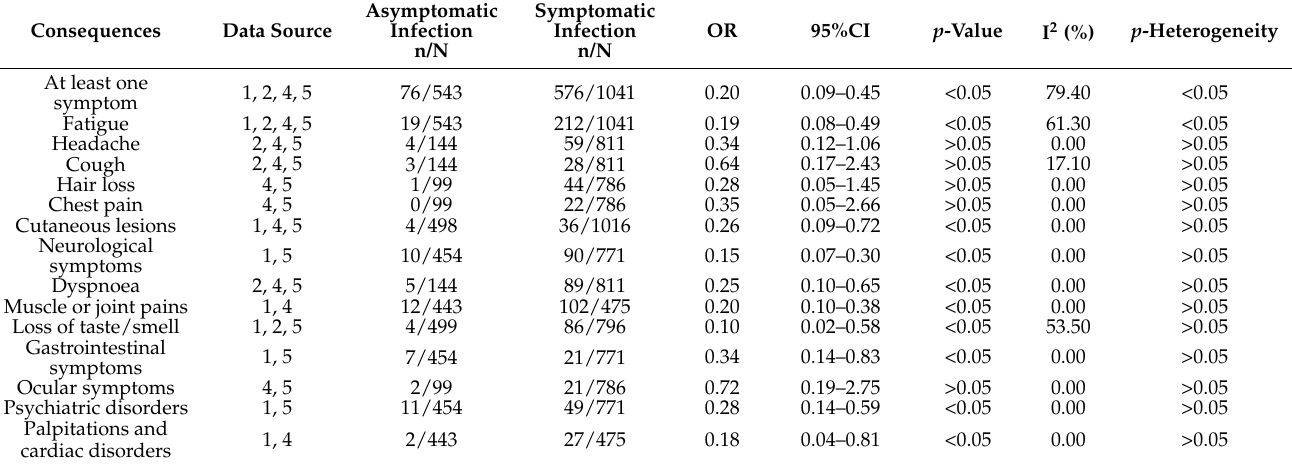
Table 4. Comparison of long-term consequences of asymptomatic and symptomatic SARS-CoV-2